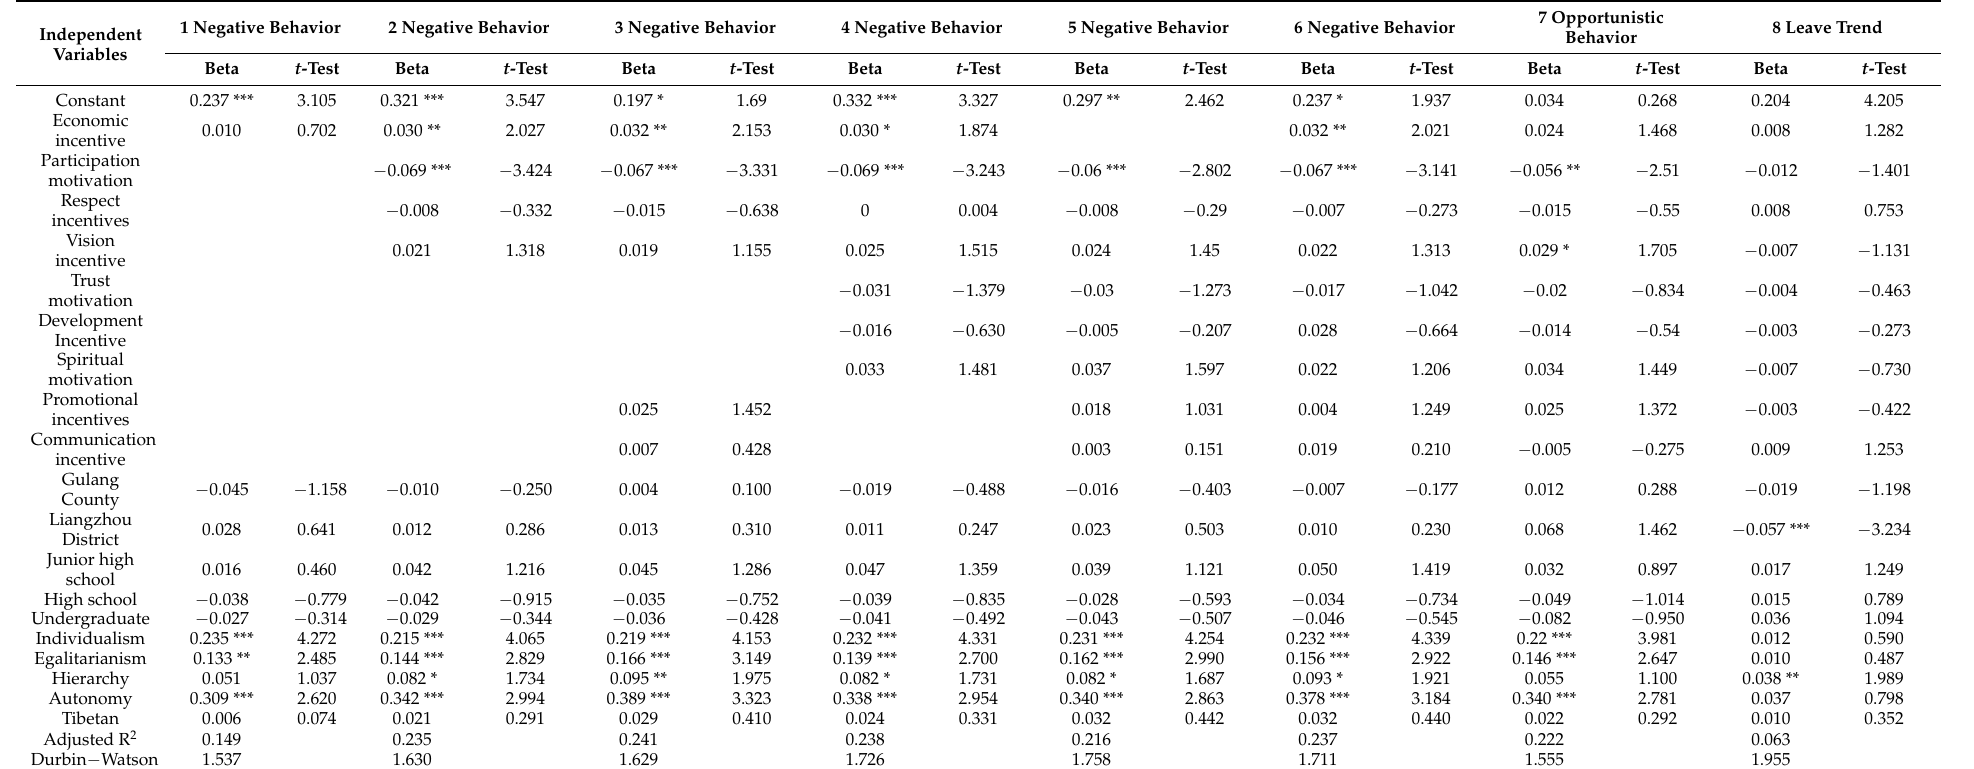
Table 2. The impact of motivation factor out of economy on negative behavior of